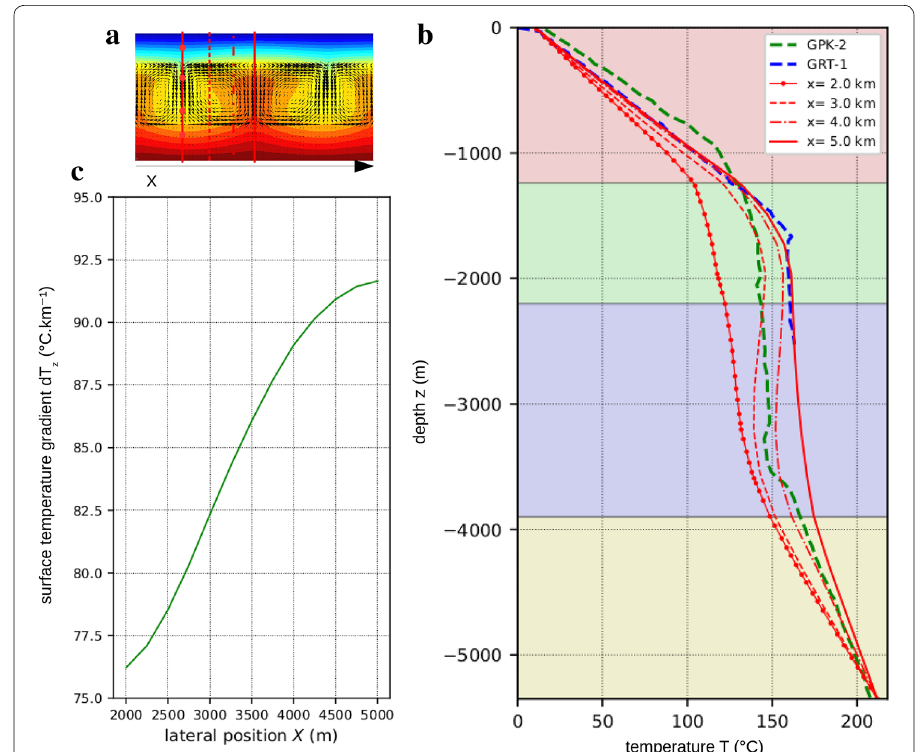
Fig. 11 a Temperature map showing the extracted temperature–depth profiles to study the lateral temperature variability. b Simulated vertical temperature profiles (as red lines) obtained every kilometer along a half-convection cell compared with the observed GRT-1 log from Rittershoffen (as blue dashed line) and GPK-2 log from Soultz-sous-Forêts (as green dashed line). c Thermal gradient obtained from the surface obtained every kilometer along a half-convection